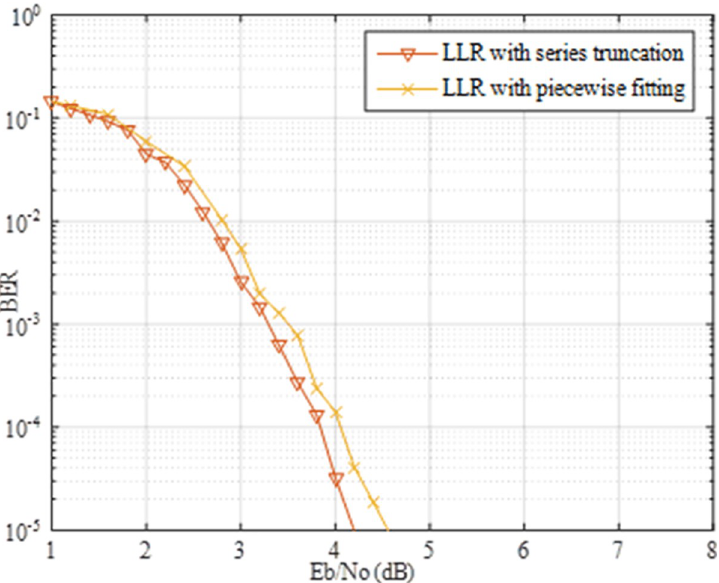
Fig 8. Performance comparison of the proposed method with piecewise